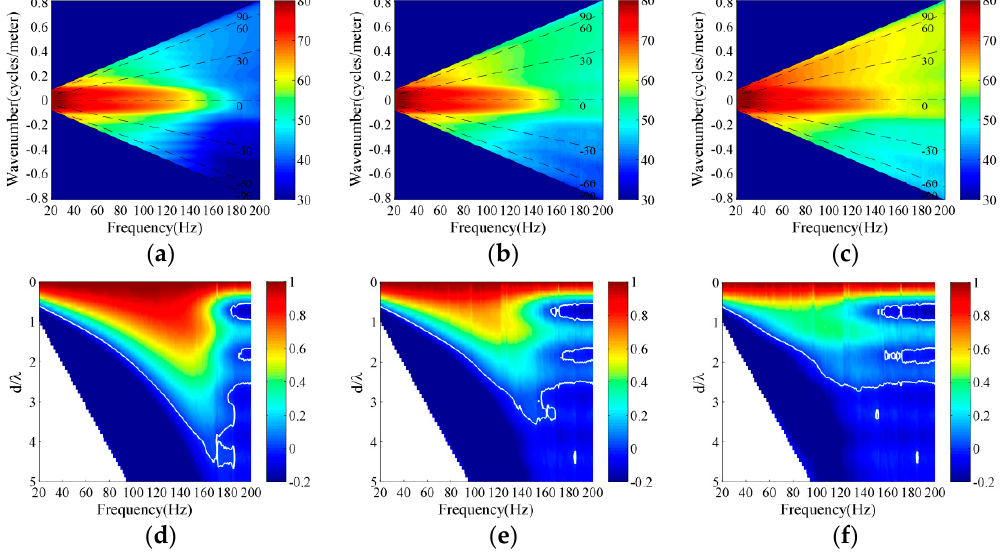
Figure 7. Frequency-wavenumber spectra and vertical correlation coefficient of the total noise field for wind speeds of ( a , d ) 3 m/s and ( b , e ) 7 m/s ( c , f ) 12 m/s.